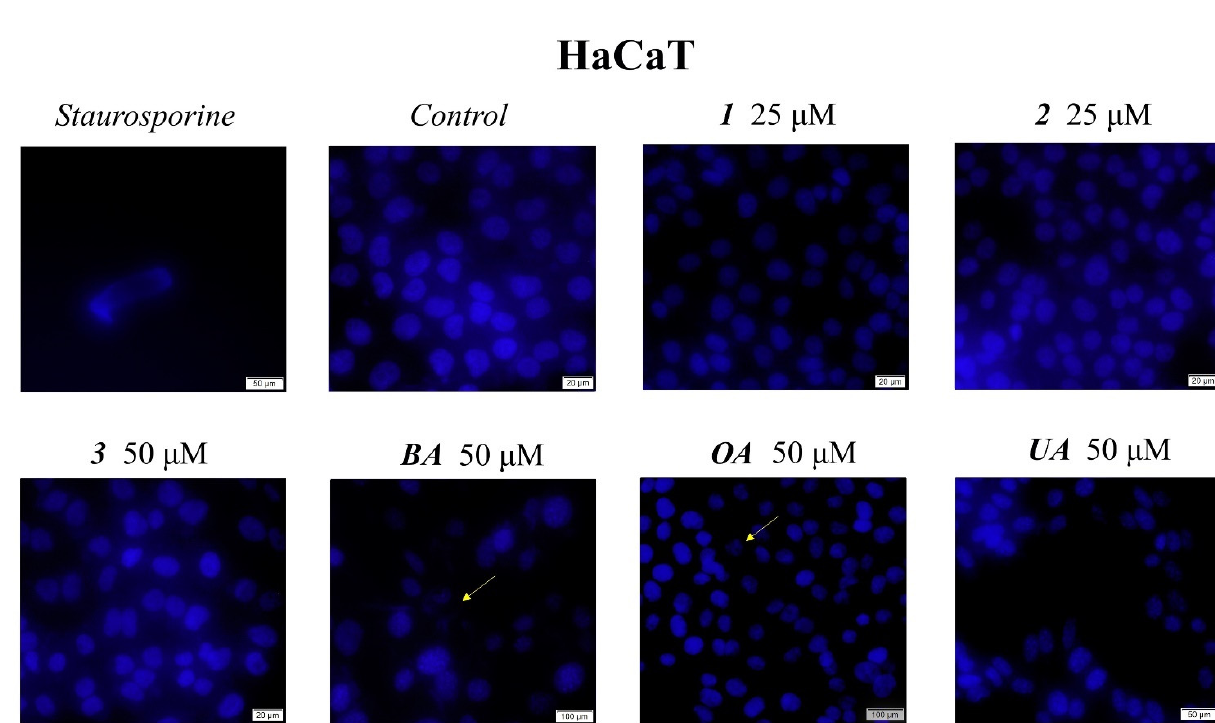
Figure 5. Nuclear staining using DAPI in HaCaT cells after treatment with 1 , 2 , and 3 (10, 25, and 50 µ M) for 24 h. The pictures were captured 24 h post-treatment. The staurosporine solution (5 µ M) was used as the positive control for apoptotic changes at the nuclear level. The yellow arrows represent signs of apoptosis, such as nuclear shrinkage, condensation, fragmentation, and cellular membrane disruption.